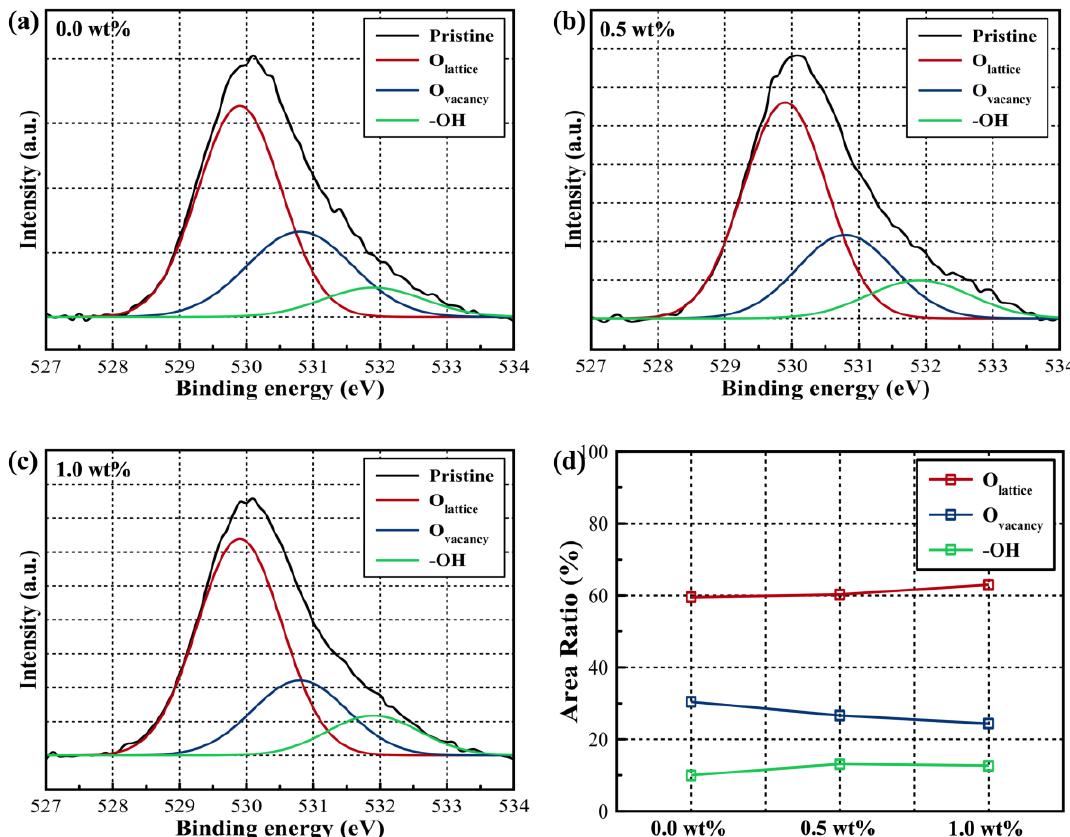
Figure 2. The O 1s XPS spectra of solution-processed SnO 2 films corresponding to different Mg doping concentrations.( a ) 0.0 wt%, ( b ) 0.5 wt%, and ( c ) 1.0 wt%. ( d )Proportions of oxygen vacancies, lattice impurities, and hydroxide impurities in Mg doped SnO 2 films, determined by XPS.